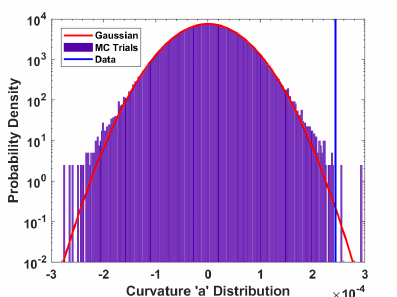
Figure 7. The distribution of the correlation curvature parameter a chosen as the supergalactic structure of multiplets test statistic for 200,000 isotropic MC sets. The purple bars are the MC PDF. The red line is a Gaussian distribution fit to the MC distribution. The data curvature is a = 2 . 4 × 10 − 4 shown as a blue vertical line.